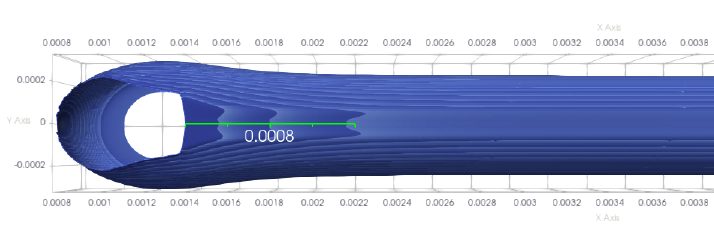
Figure 23. Interface of the strand obtained with a sinusoidal substrate velocity. The ruler has a length of 0.8